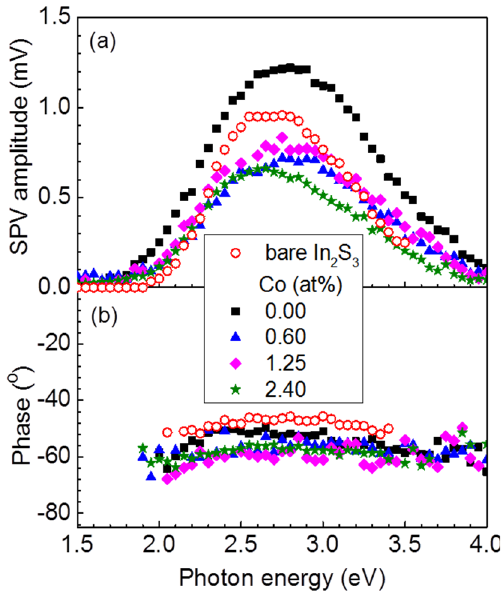
Figure 3. ( a ) Modulated SPV amplitude; and ( b ) phase angles for TiO 2 and CTO thin films doped with 0.6 at %, 1.25 at %, and 2.40 at % of Co.